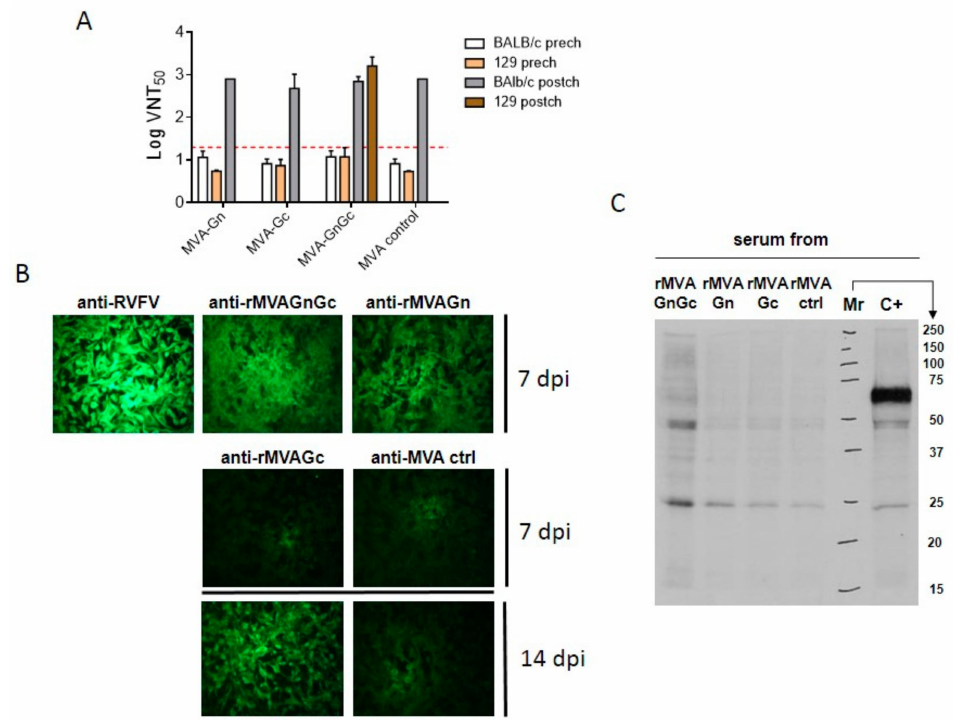
Figure 3. Humoral responses upon MVA vaccination in mice. ( A ). Virus neutralization titers (VNT) in serum samples taken 14 days after immunization (prech.) of either BALB / c or 129SvEv mice. Neutralization titers were also estimated in mice that survived the challenge (postch.). Bars represent mean plus SD. ( B ). Detection of RVFV-infected cells by IFA with serum from MVA vaccinated mice at 7 or 14 days post immunization (dpi). The figure shows representative images of viral plaques detected on cells. ( C ). Immunoprecipitation of RVFV-infected BHK21 cell extracts with serum from MVA vaccinated BALB / c mice. C + : positive control serum from mice immunized with an adenovirus vector encoding GnGc. Mr: relative mass in